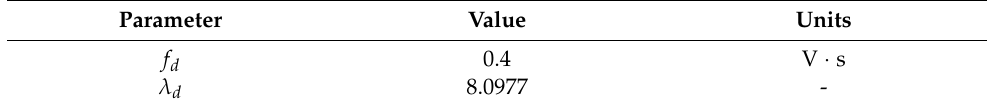
Table 3. Desired values for SCIG control.